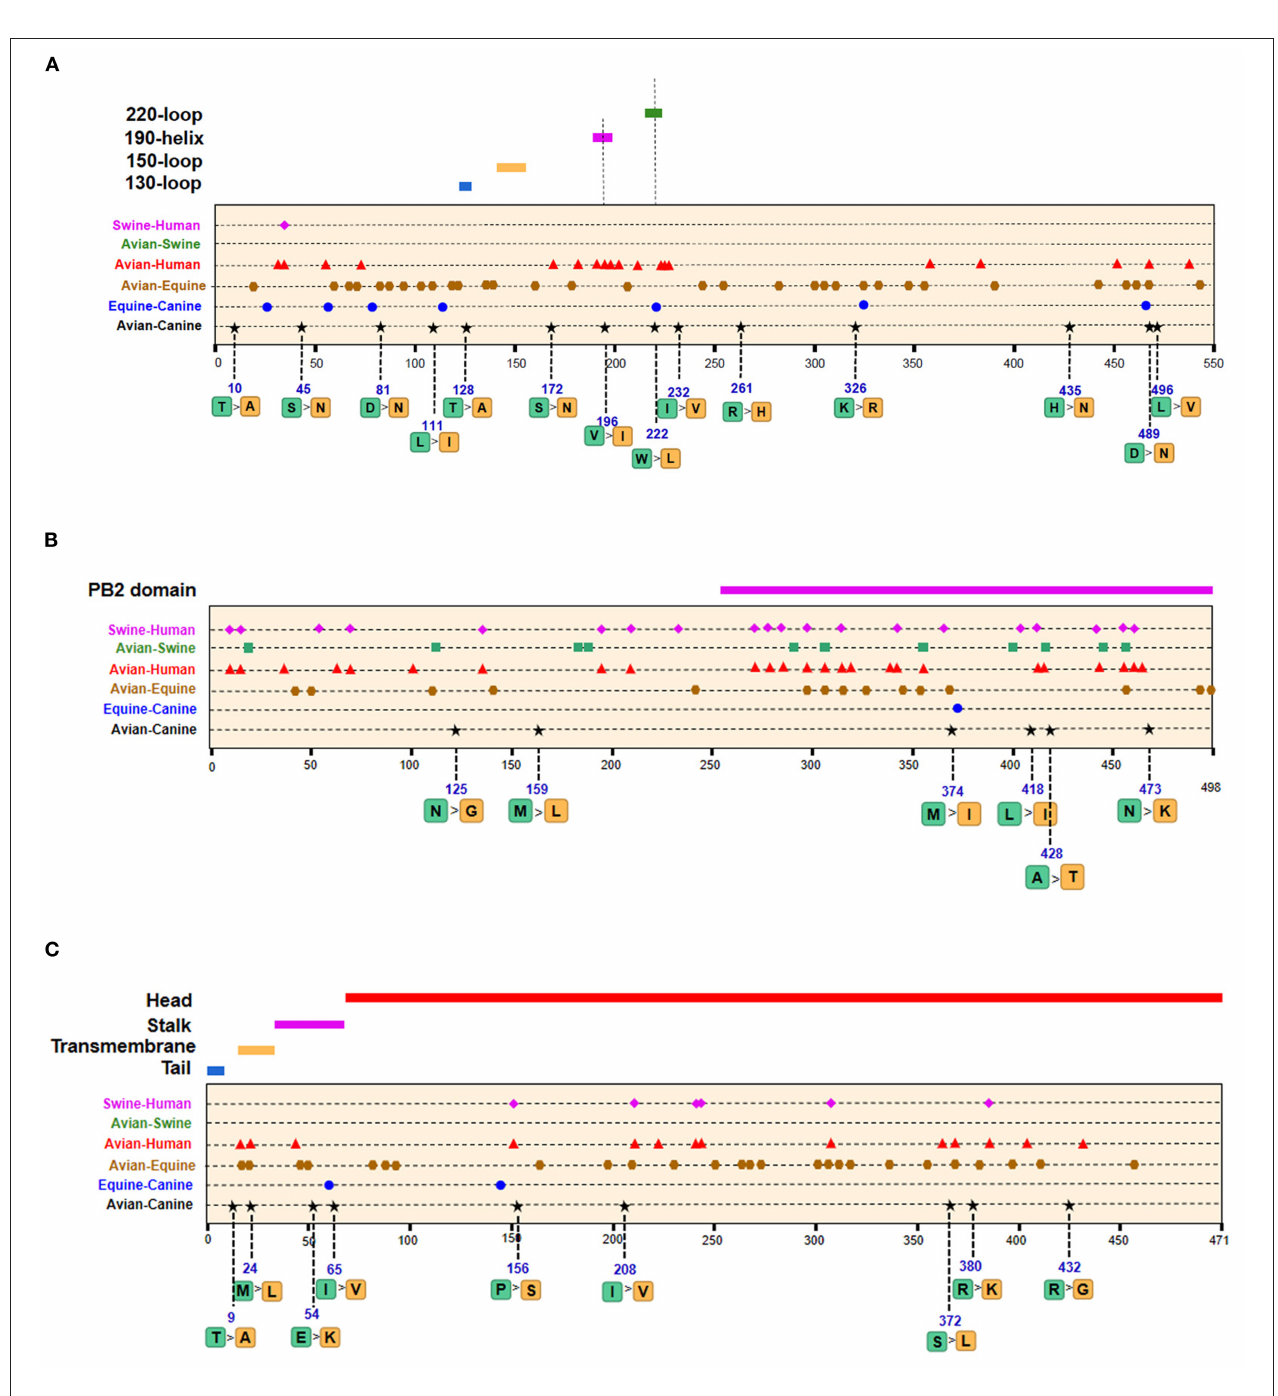
FIGURE 5 | Positions of identified signatures in structural and functional domains of HA (A) , NP (B) , and NA (C) proteins. The positions and dominant amino acid residues of Avian → Canine (H3N2) signatures are placed below the pale-yellow bar. Black star: Avian → Canine (H3N2), blue circle: Equine → Canine (H3N8), brown hexagon: Avian → Equine (H3N8), red triangle: Avian → Human (H3N2), green square: Avian → Swine (H3N2), and purple triangle rhomb: Swine → Human (H3N2). The detail of these signatures are in Table 2